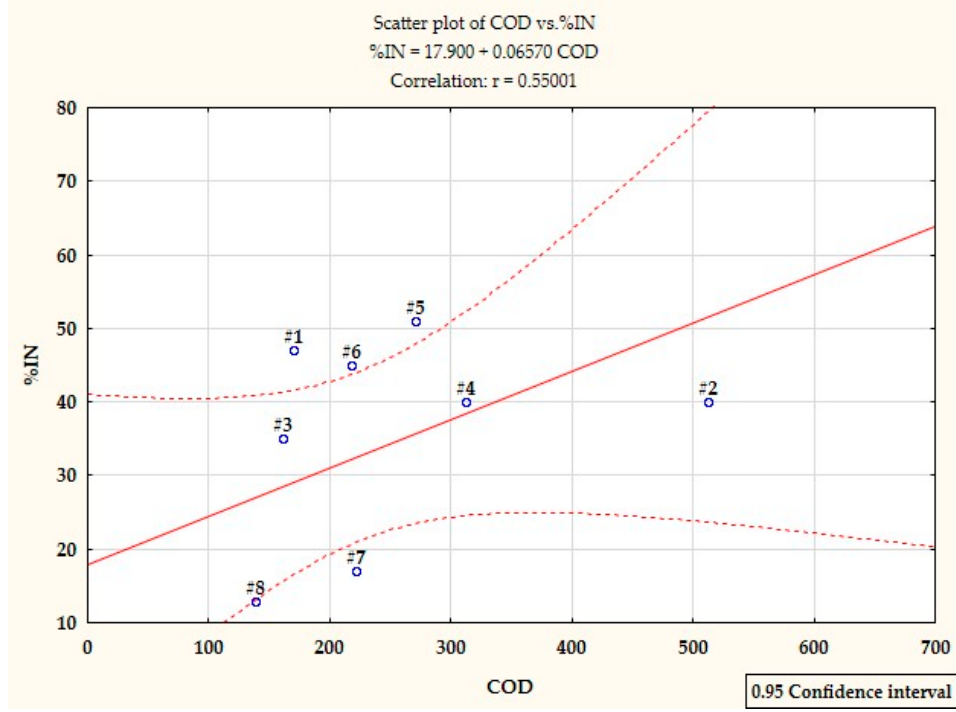
Figure 7. Scatter plot showing the strength of the correlation between% IN and COD of wastewater filtered in ash basins: #1 styrene butadiene rubbers; #2 solvents: butyl acetate, ethyl acetate; #3 styrene; #4 acrylonitrile rubbers; #5 terpenes; #6 emulsifiers; #7 polyvinyl acetate; #8 polyvinyl chloride; #9 methacrylate.